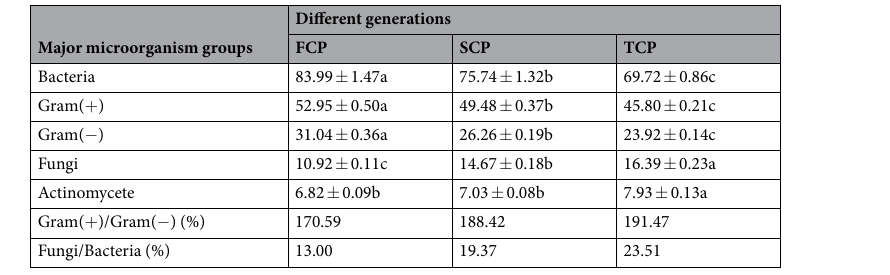
Table 3. The statistics of major microorganism groups (ug·g − 1